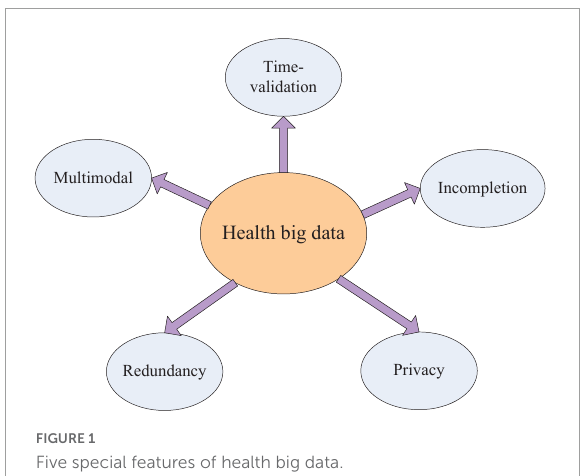
FIGURE1 Five special features of health big